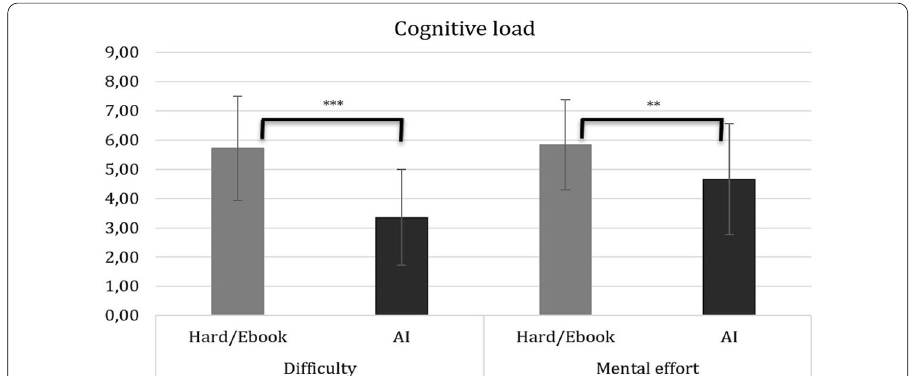
Fig. 3 Comparison of cognitive load levels between students using the hardcopy/E‑book versus the AI‑enriched book. ***Difference is sig. at the 0.001 level (2‑tailed); **difference is sig. at the 0.01 level (2‑tailed)